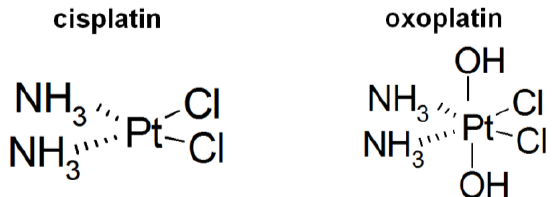
Figure 1. Structural formulas of cisplatin and